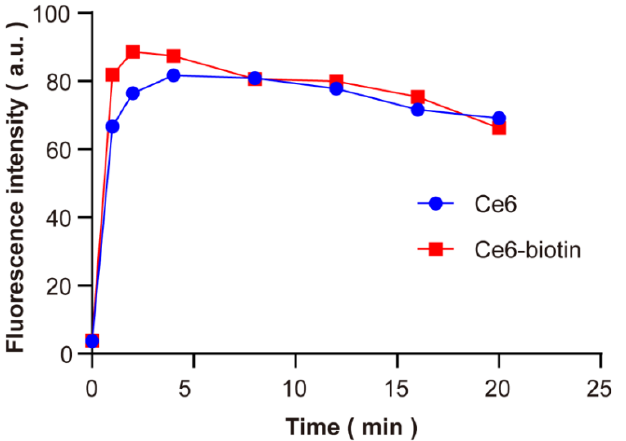
Figure 3. Comparison of the fluorescence of SOSG at 530 nm in PBS using Ce6 and Ce6-biotin as photosensitizers after being irradiated by 660 nm (1 W·cm − 2 ) laser up to 20 min. Table 1. Photochemical data for Ce6 and Ce6-biotin.